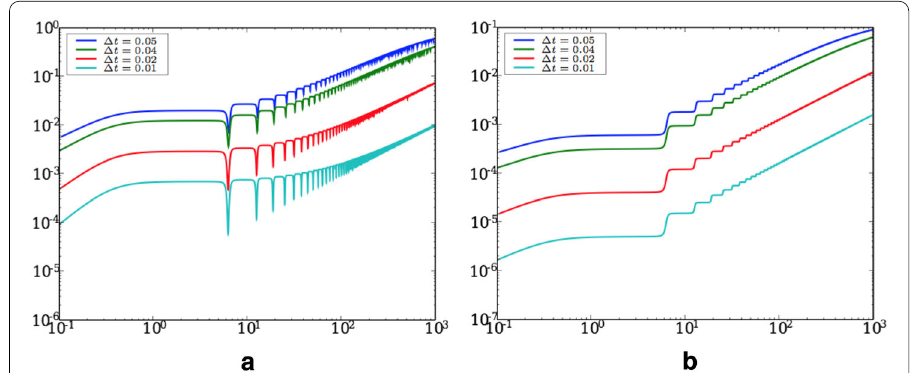
Fig. 3 Kepler’s problem. Evolution of the relative error on the Hamiltonian and the angular momentum with the second-order Runge–Kutta scheme. a Error on H over time. b Error on (cid:10) over time